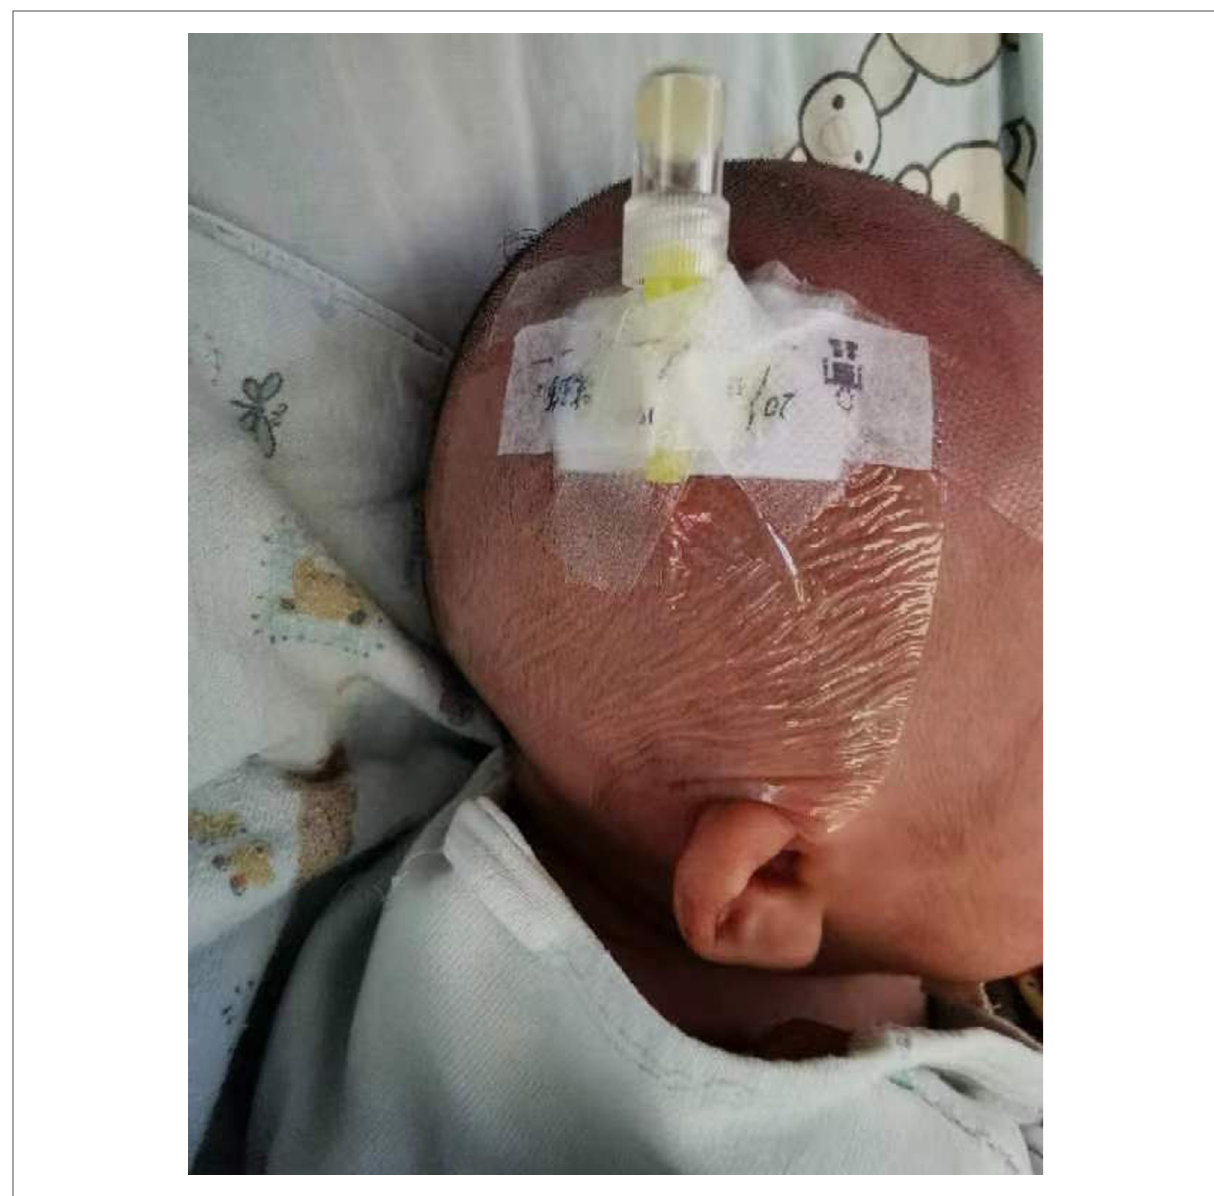
FIGURE 2 Scalp indwelling needle puncture and fi xation in the right super fi cial temporal